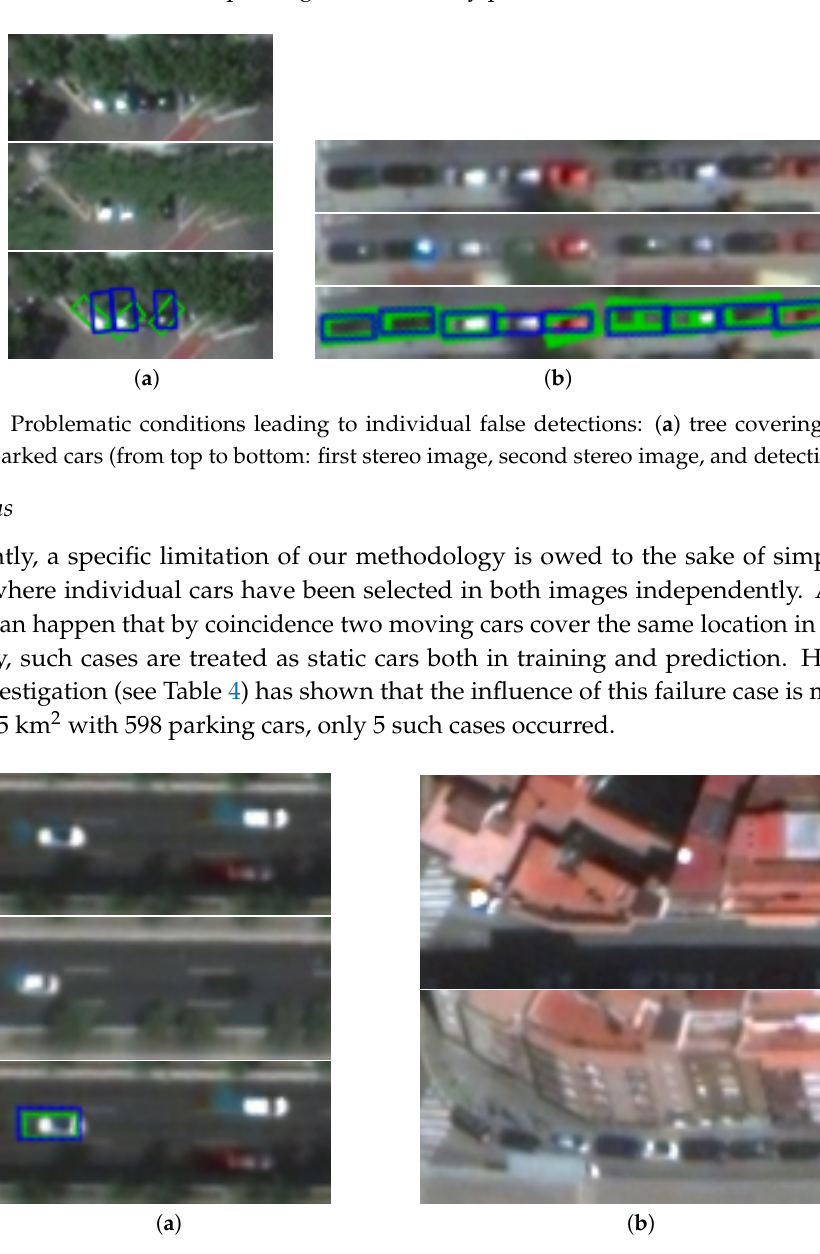
Figure 9. Limitations of our proposed method: ( a ) two different cars covering the same spot lead to a false positive detection and ( b ) cars parked closed to high buildings are occluded in one of the stereo